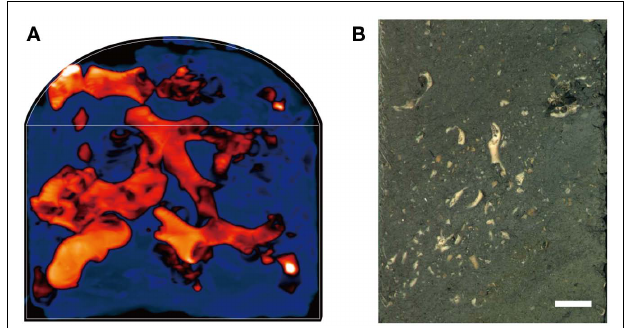
FIGURE 1 |An example of core samples that contain coral fossils. (A) A 3D X-ray CT scan image of a half-round core sample from 20mbsf (Sample code: 3H-3). Orange-red color indicates the buried coral fossils, while dark blue indicate the sediment matrix. (B) A photo image of half-round core surface (3H-3). Scale bar: